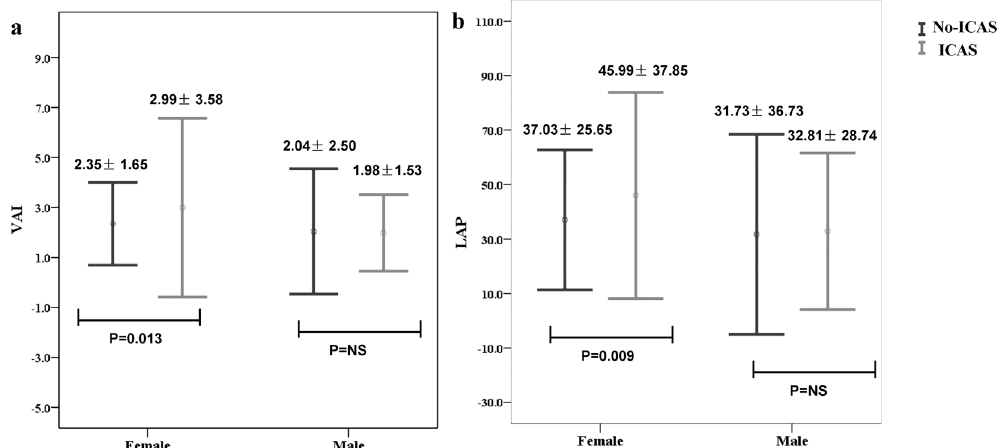
Figure 2. VAI ( a ) and LAP ( b ) in different genders according to presence or absence of ICAS. Data are mean ± SD. Error bars show SD. SD, standard deviation; LAP, lipid accumulation product; VAI, visceral adiposity index; ICAS, intracranial atherosclerotic stenosis; No-ICAS, no intracranial atherosclerotic